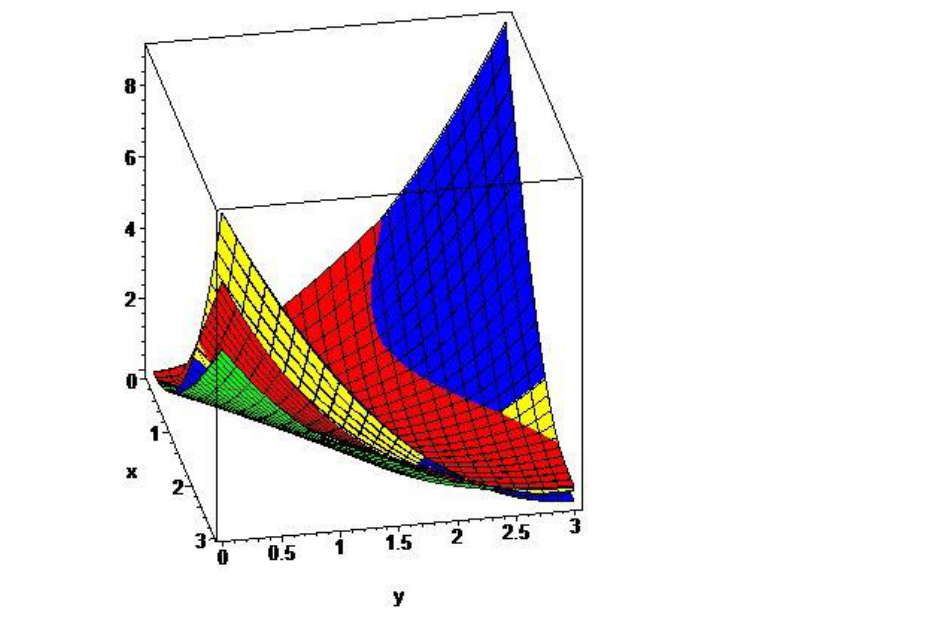
Figure 5. Comparison by Approximation of R 75,75 ( ϕ ) (green), R G to ϕ (blue) on [ 0,3 ] × [ 0,3 ]